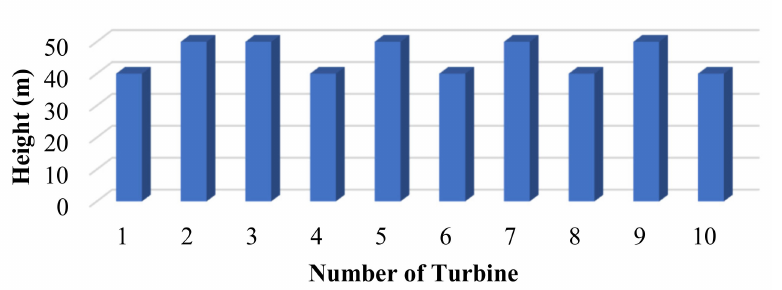
Figure 8. Heights of turbines in Case 1.